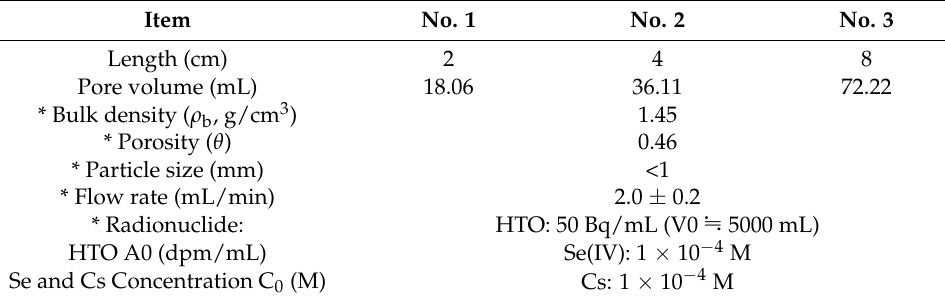
Table 1. The ADE experimental conditions in this study.